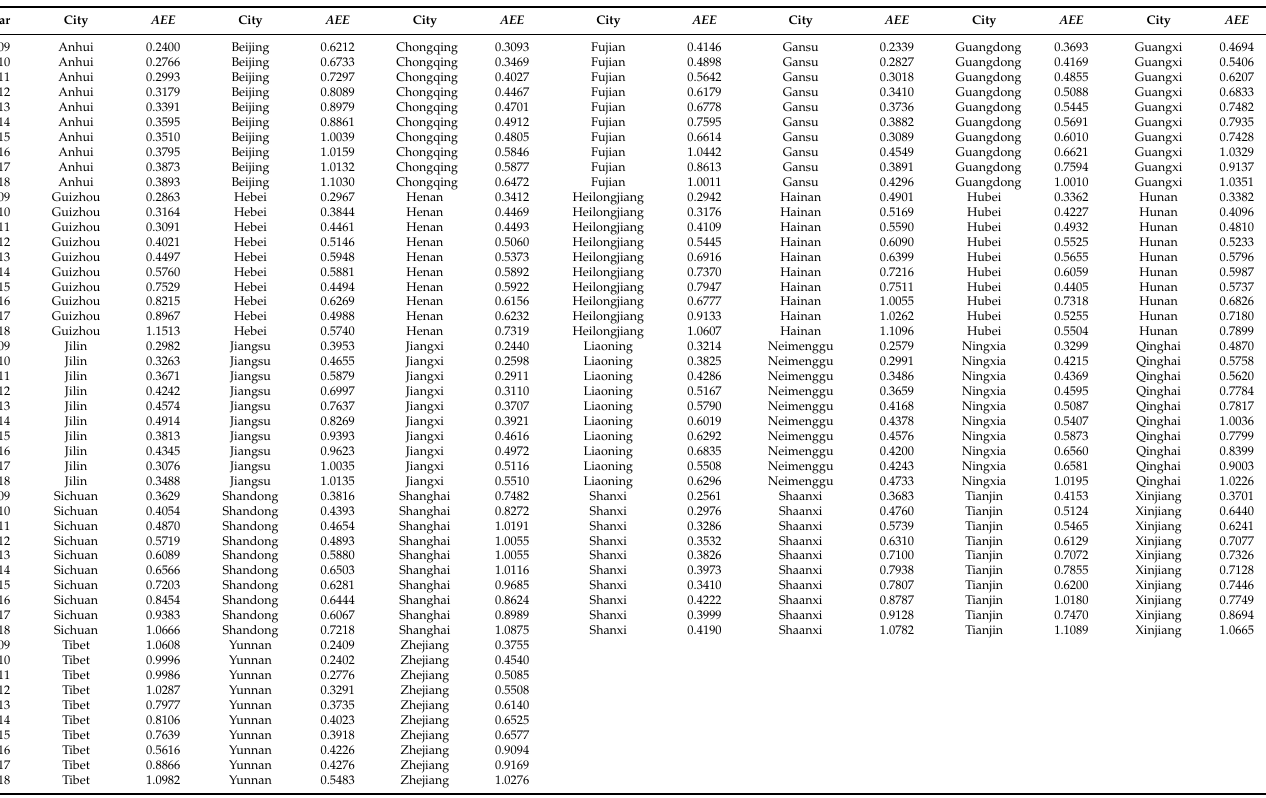
Table A1. Agricultural eco-efficiency